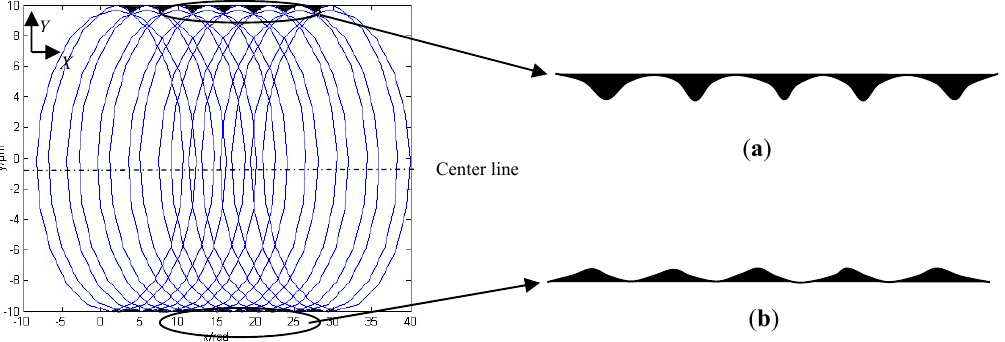
Figure 4. The micro groove surface topography considering total radial run out. ( a ) Up milling. ( b ) Down milling.